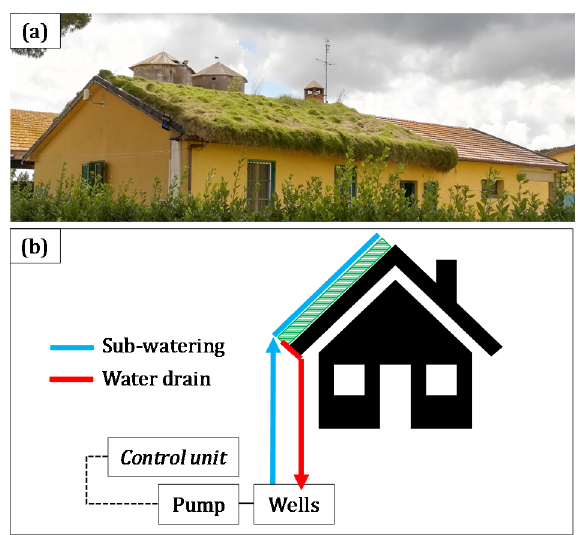
Figure 1. ( a ) Single-story building on which the green roof is installed and ( b ) roof-lawn whole system (an elaboration from [20]).